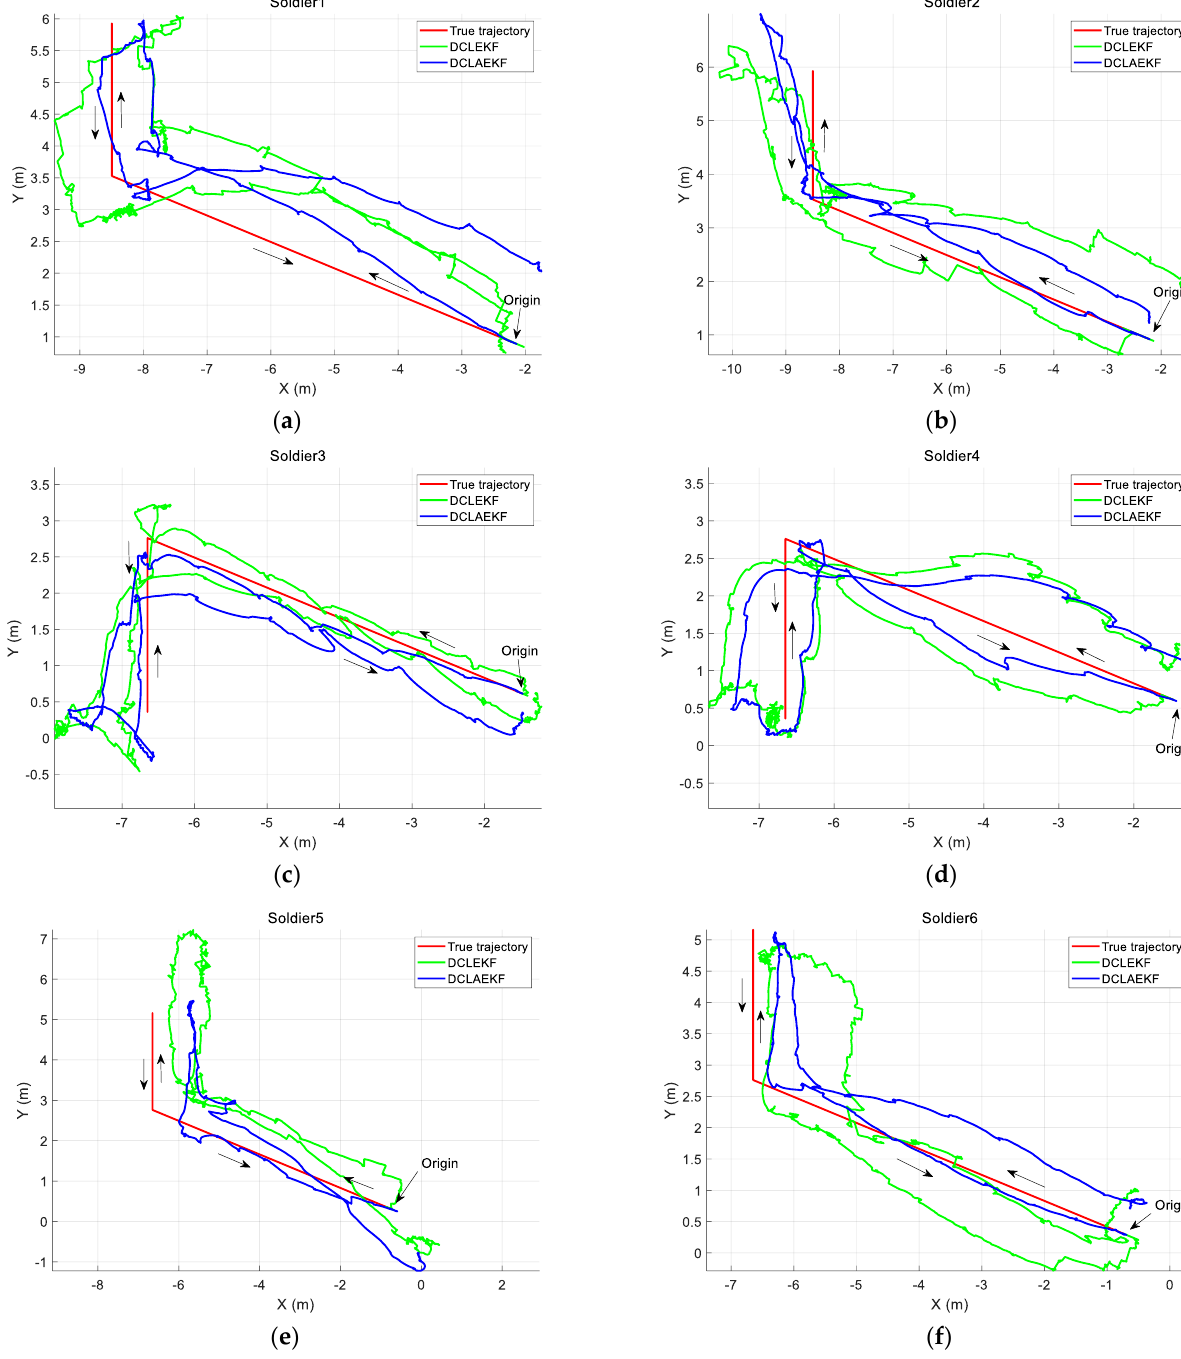
Figure 7. Localization results of soldiers using different algorithms in a building environment experiment. ( a ) Localization results of soldier 1; ( b ) Localization results of soldier 2; ( c ) Localization results of soldier 3; ( d ) Localization results of soldier 4; ( e ) Localization results of soldier 5; ( f ) Localization results of soldier 6.